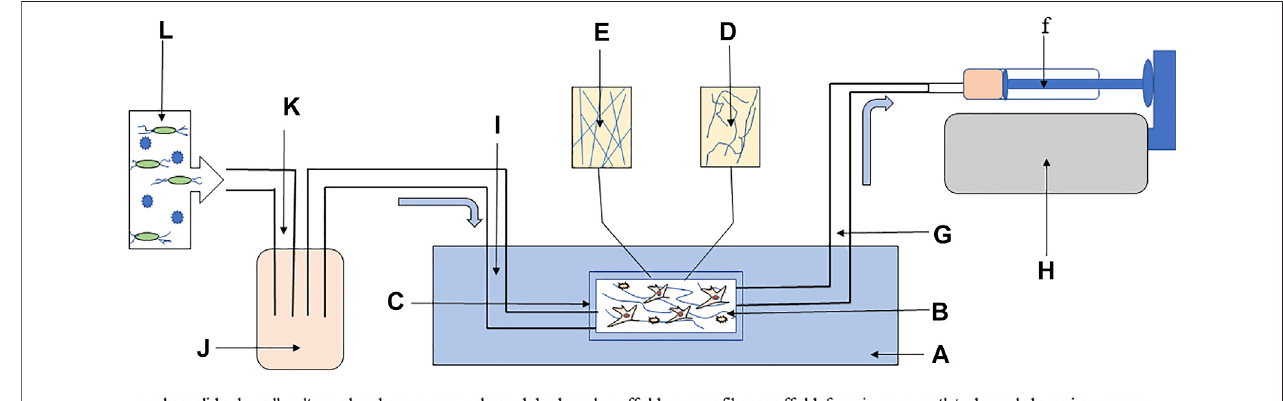
FIGURE 3 | Simpli fi ed scheme using 3D cell culture with micro fl uidic system to study host – pathogen interactions. The main part of the system is a glass slide with chamber covered by glass coverslip, where hydrogels or nano fi bers scaffold can be included. In the cell culture chamber, mesenchymal stem cells (MSC) and hematopoietic stem cells (HSC) can be cocultured on scaffold. The chamber is connected to a syringe by outlet channel, and fl ow of medium is produced by syringe pump through negative pressure. Cell culture medium is introduced into the chamber by inlet channel from the vessel. To study host – pathogen interactions, the medium vessel can be enriched via the inlet for inclusion of pathogens or other stimulants, such as metabolites, toxins, vitamins, or minerals. Adapted from Kim et al. (2019).